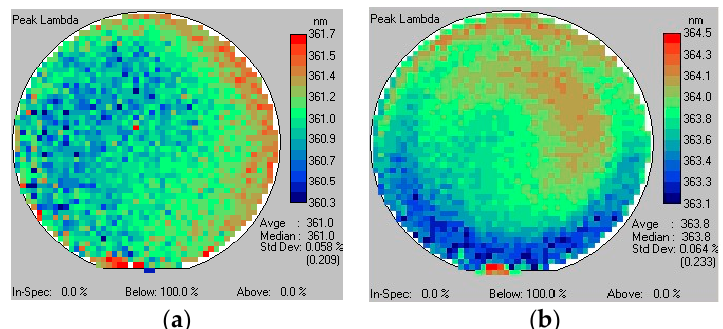
Figure 4. PL mapping of GaN grown on Si substrate ( a ) with and ( b ) without the two-step growth method.